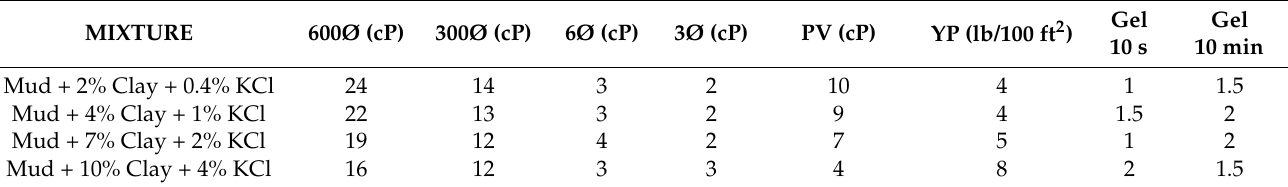
Table 4. Rheological properties for the mud at different concentrations of KCl.